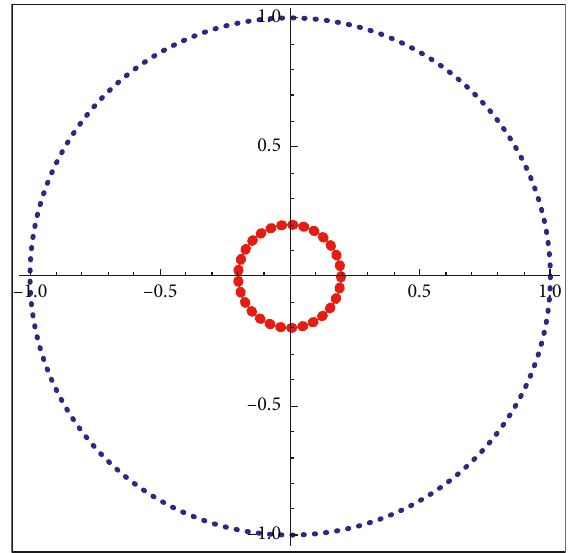
Figure 1: Annulus region Ω for Example 1.